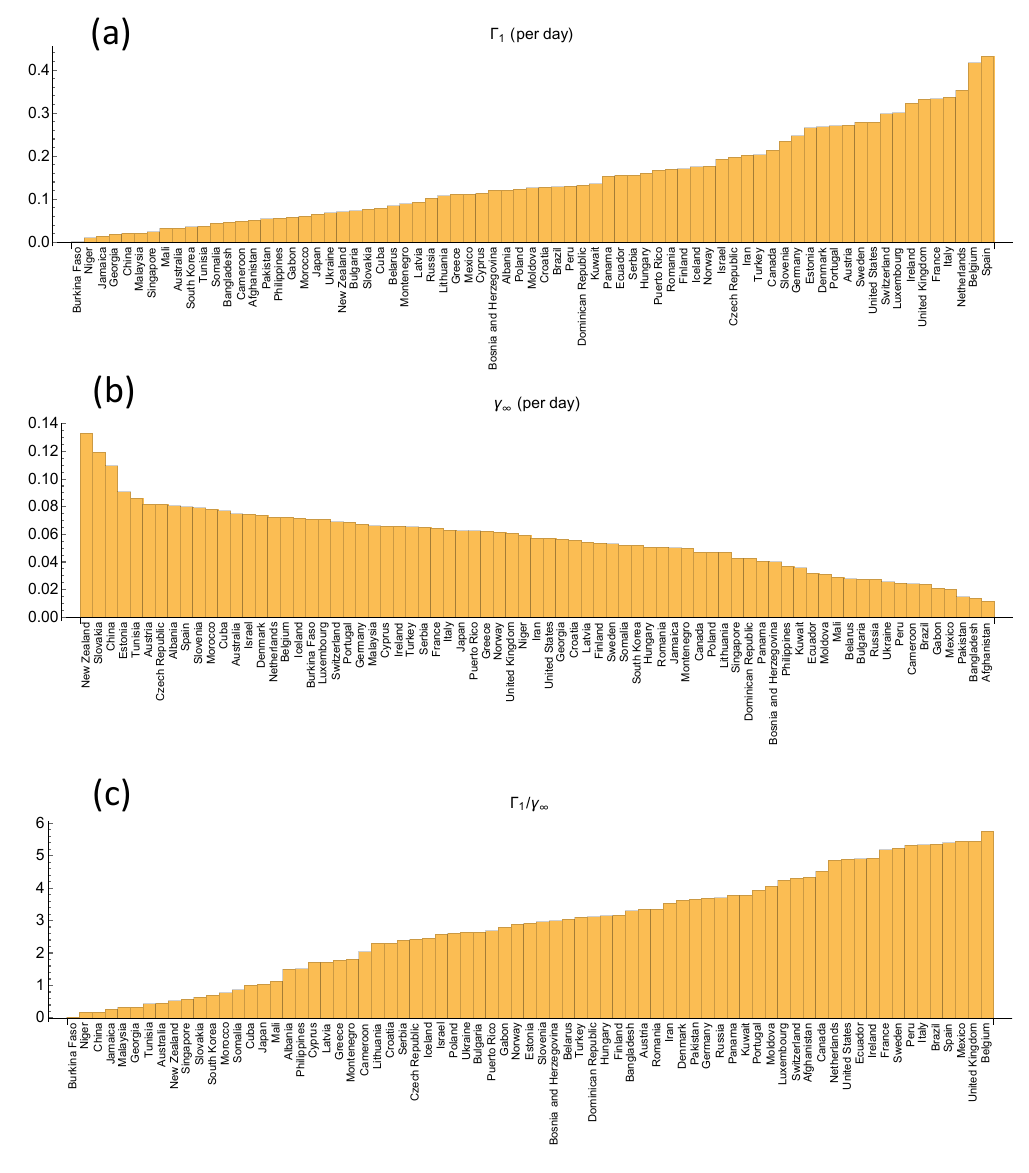
Figure 7. ( a ): Estimated Γ 1 for the 73 countries ranked from lower to higher values. ( b ): Estimated γ ∞ ranked from high to low values. ( c ): Estimated Γ 1 / Γ ∞ = ln J ∞ ranked from lower to higher